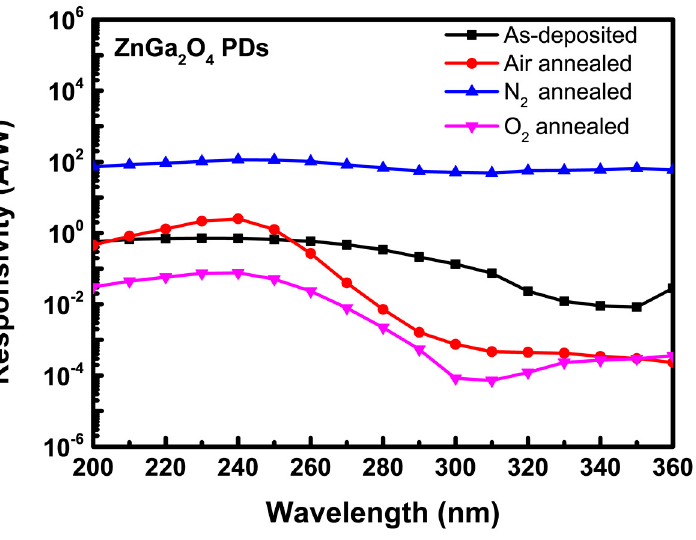
Figure 7. Spectral response of as-deposited and annealed ZnGa 2 O 4 PDs under different annealing ambiences. Table 1. Comparison of some key performance of our ZnGa 2 O 4 PD with other previously reported ZnGa 2 O 4 PDs. Table 1. Comparison of some key performance of our ZnGa